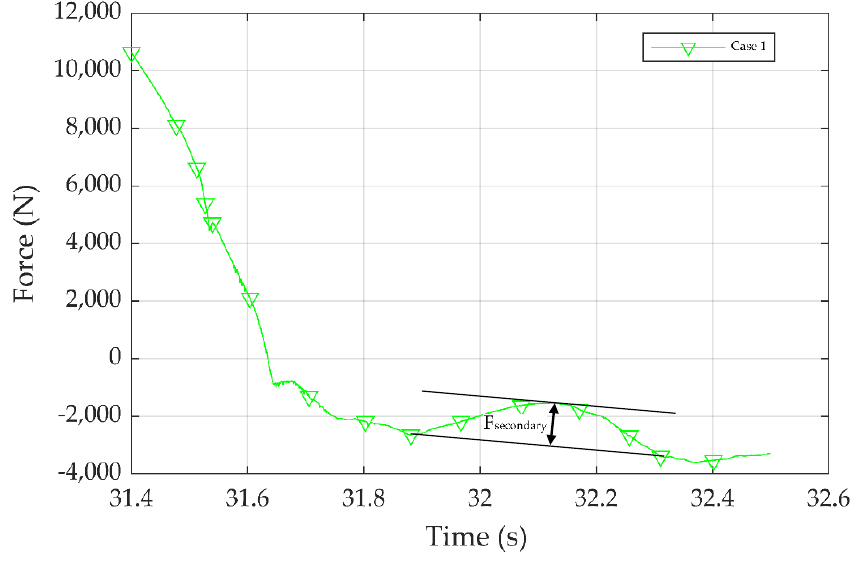
Figure 17. The magnitude of the secondary load, F secondary .